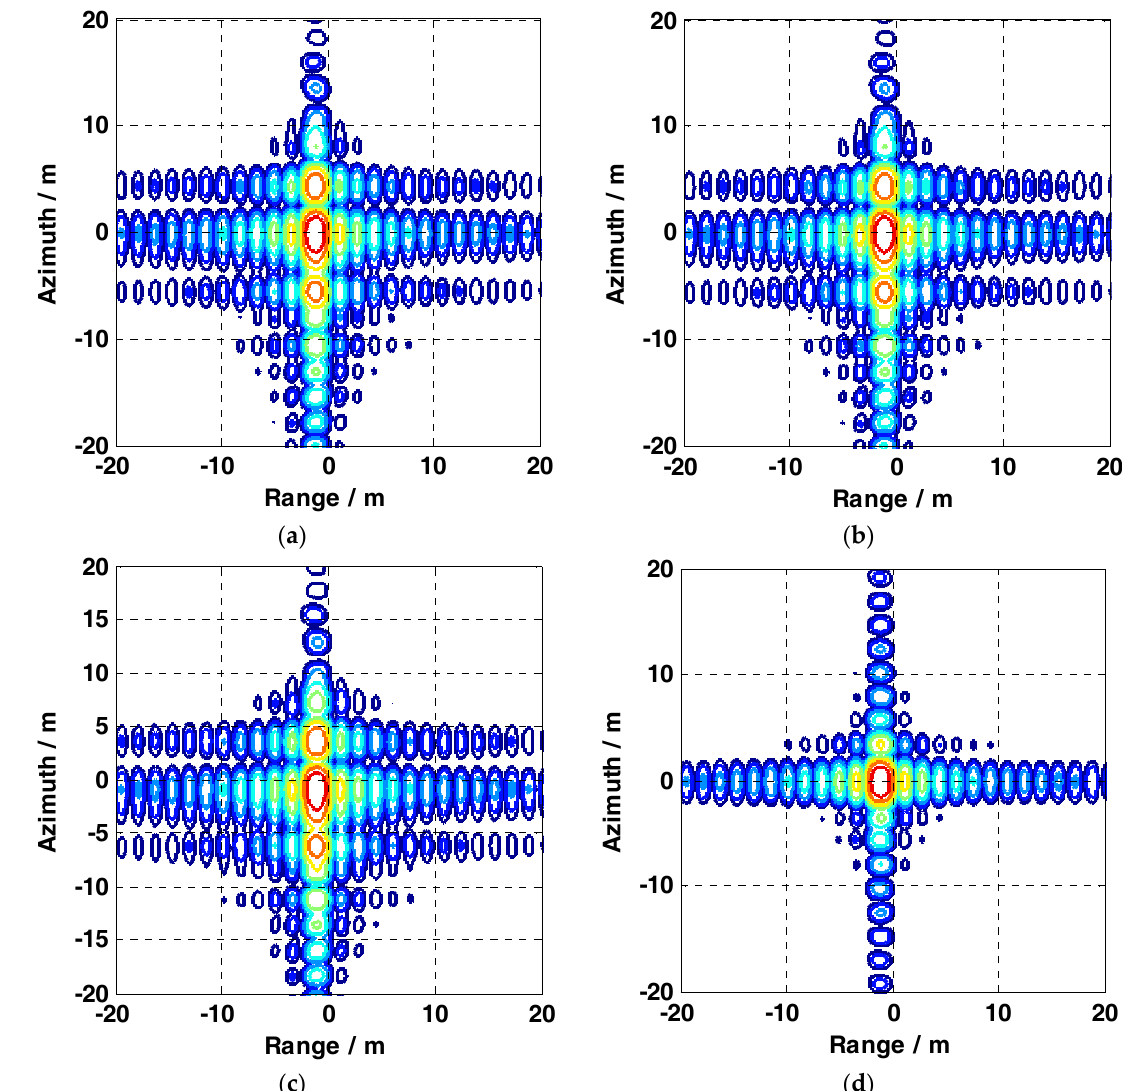
Figure 21. Target 5’s contours processed by ( a ) the conventional SAR imaging algorithm (CS algorithm), ( b ) the MD algorithm, ( c ) the PGA algorithm, and ( d ) the BLUE algorithm, for strip SAR data with high ‐ order sine residual motion error.